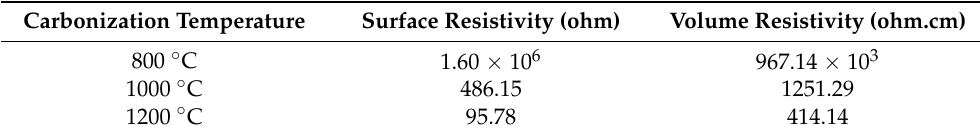
Table 4. Effect of carbonization temperature on electrical resistivity of activated carbon fabric.